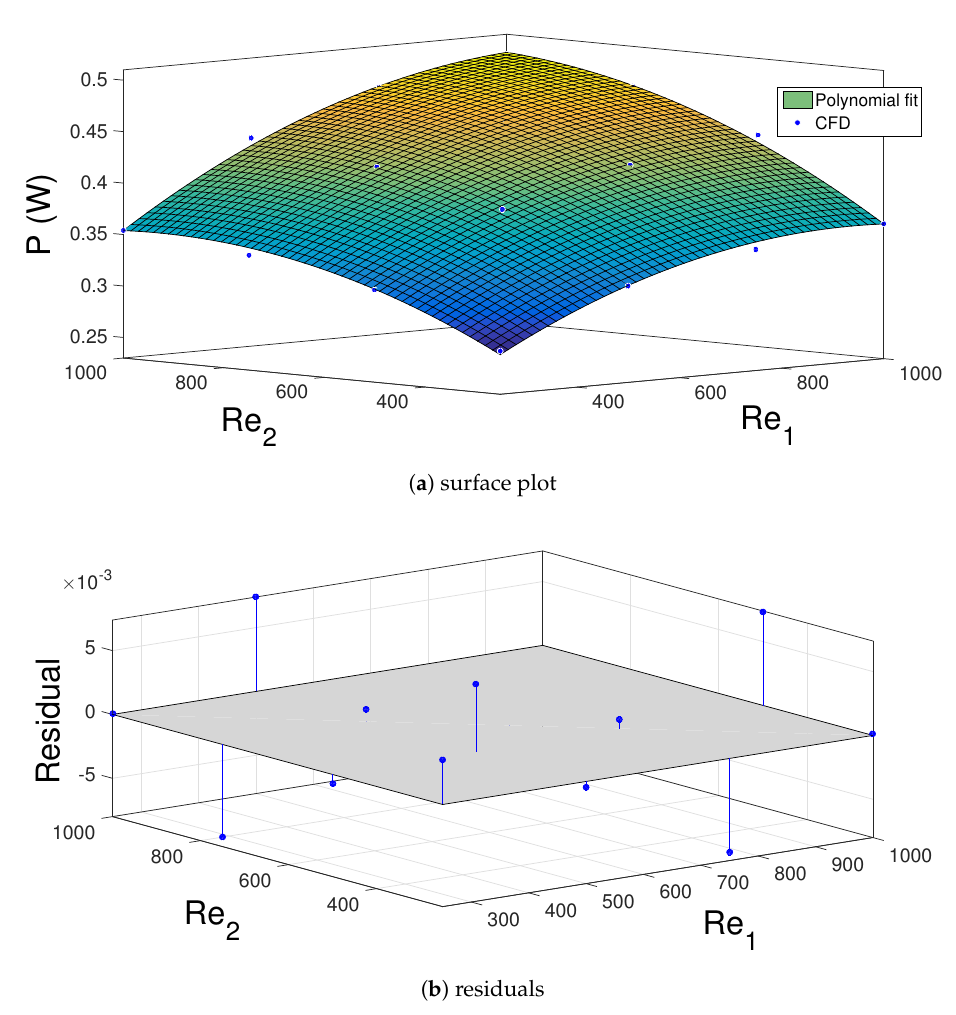
Figure 16. Polynomial surface fit ( a ) and residual ( b ) plot for the generated TEG power with varying jet stream Reynolds numbers at φ = 0.02.